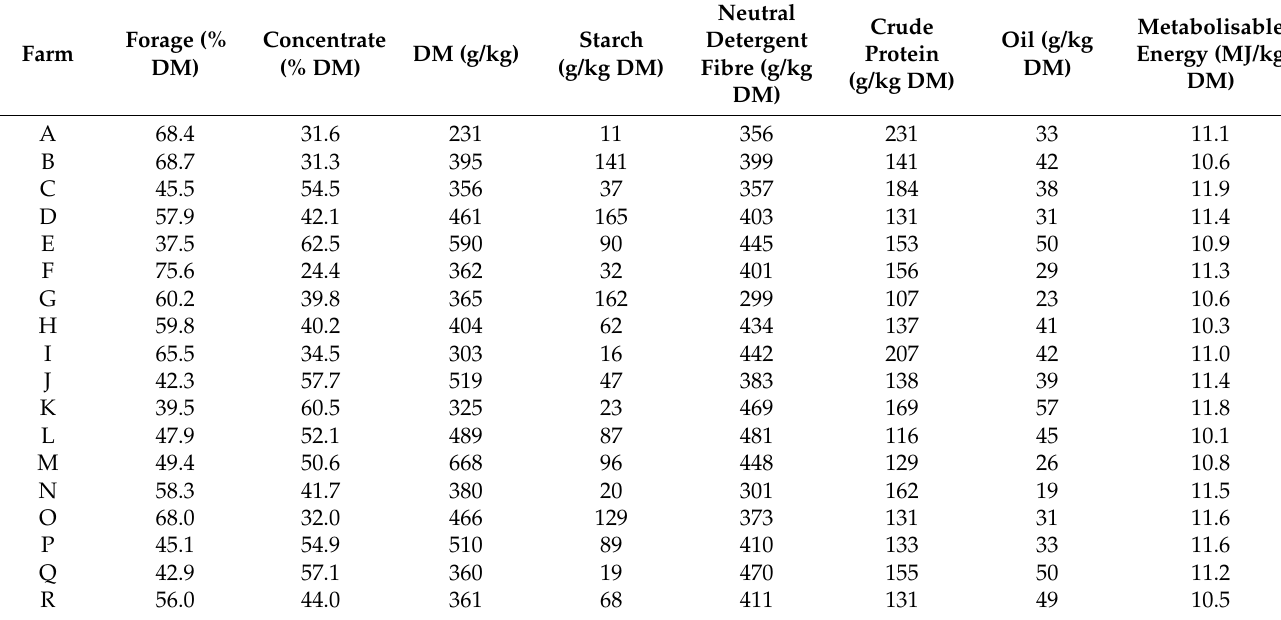
Table 2. Forage and concentrate percentage and nutrient content in the dry matter (DM) of the diet for each farm (A to